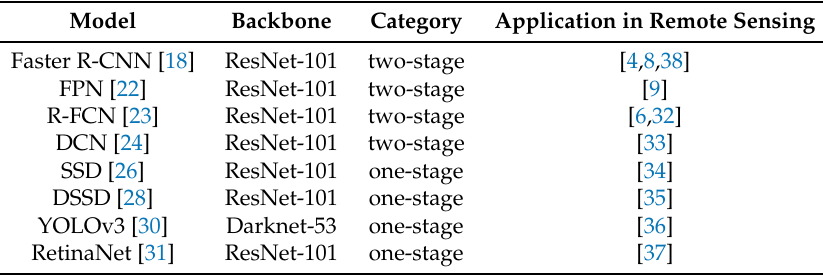
Table 1. Information of eight